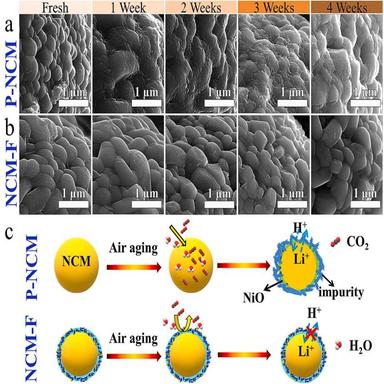
Surface morphology evolution of (a) P-NCM and (b) NCM-F during air aging. (c) Schematic diagram of P-NCM and NCM-F during air aging.